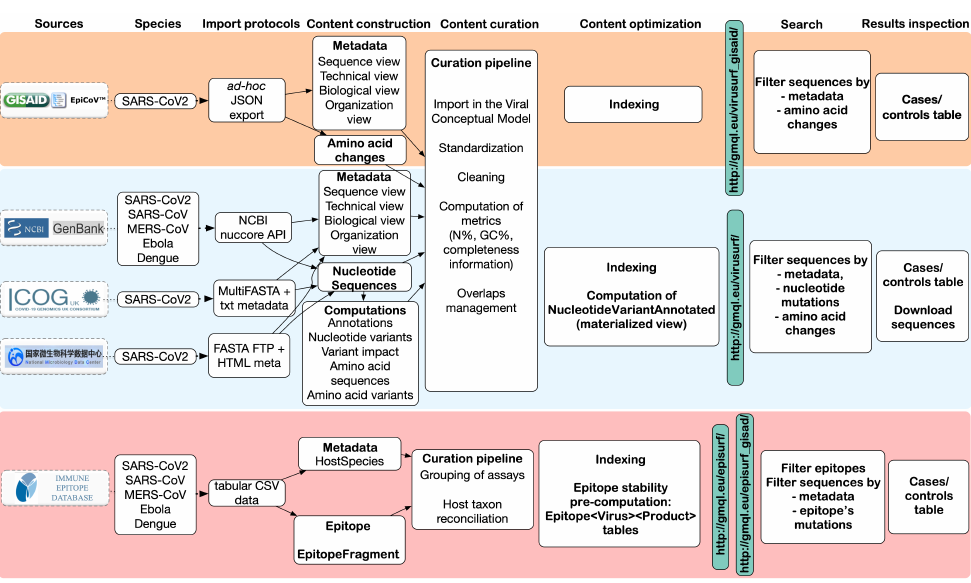
Figure 2. Overview of the data flow and pipeline stages for the integration of viral sequences into ViruSurf and EpiSurf. The top row highlights the principal stages of the data integration process and the final result, as observed from the interfaces (last two columns). The data sources are listed vertically on the left